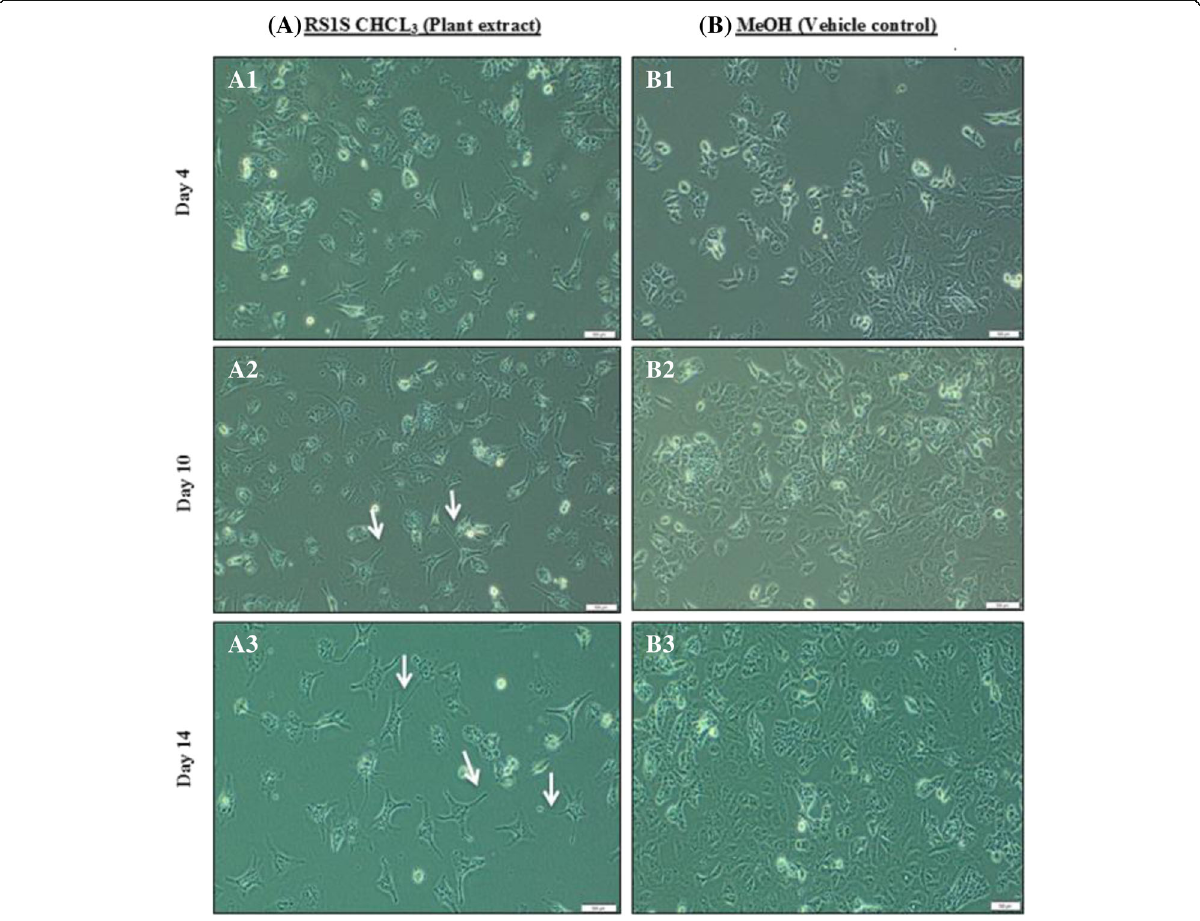
Fig. 6 Timeline of NT2 cell differentiation with plant extract. (A1) On day 4, the morphology of NT2 cells with 5 μ g/ml of RS1S CHCL3 had begun to change. (A2) On day 10 and (A3) on day 14, the NT2 cells showed short neurites that developed from day 4 until day 14. During incubation, NT2 cells were treated with 5 μ g/ml of RS1S CHCL3. (B1, B2 and B3) Vehicle control (0.001% MeOH) cells maintained their morphology over the 14 days. Scale bar, 500 μ m. Magnification (10×). Arrows indicate neurite